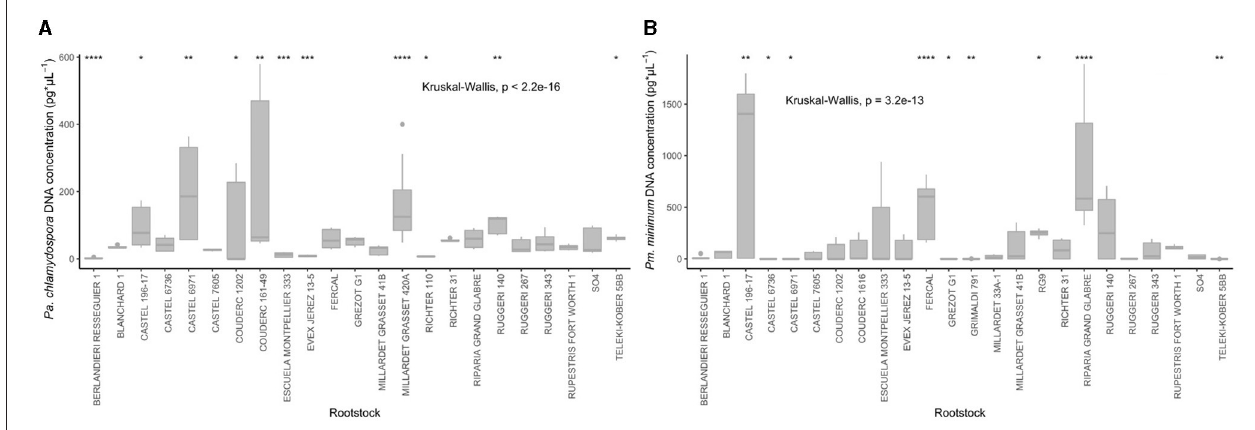
FIGURE 1 | Box plots of the fungal DNA concentration found in differing grape rootstock varieties. (A) Phaeomoniella chlamydospora DNA concentration in pg/ µ l considering an initial wood mass for the analysis of 50mg. (B) Phaeoacremonium minimum DNA concentration in pg/ µ l considering an initial wood mass for the analysis of 50mg. Significance (* P < 0.05, ** P < 0.01, *** P < 0.001, and **** P < 0.0001) determined by the Wilcoxon rank sum